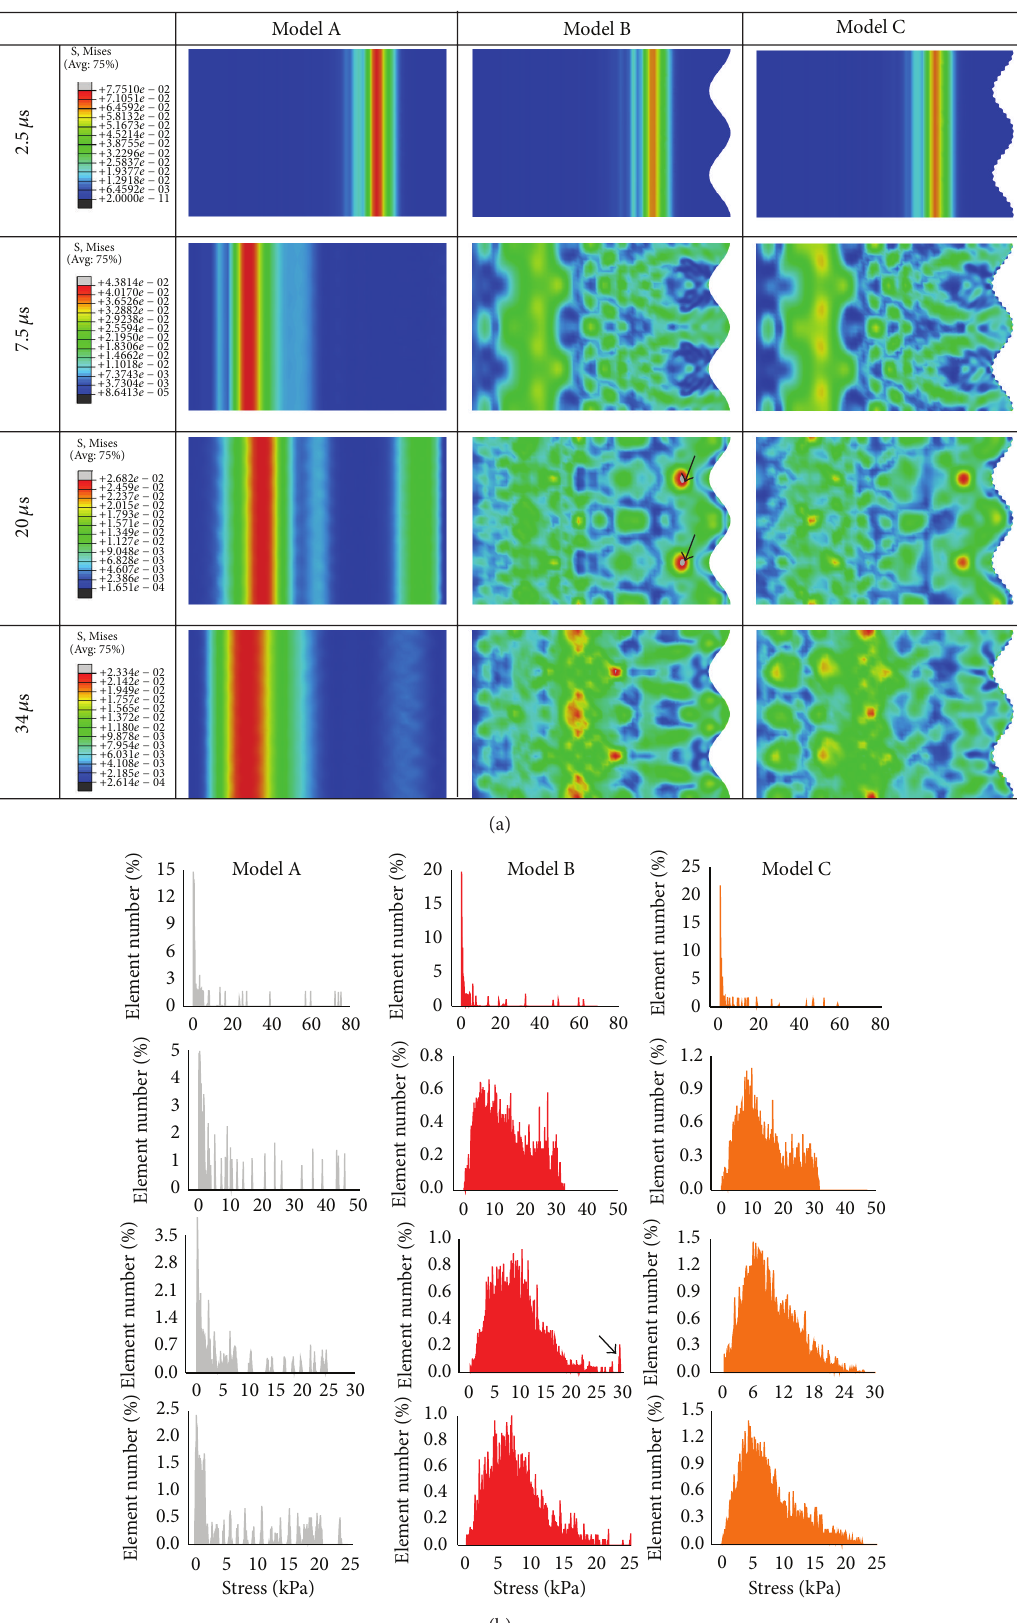
Figure 5: Distribution of von Mises stress in L-bone for different suture models: (a) contours of von Mises stress field and (b) the corres- ponding